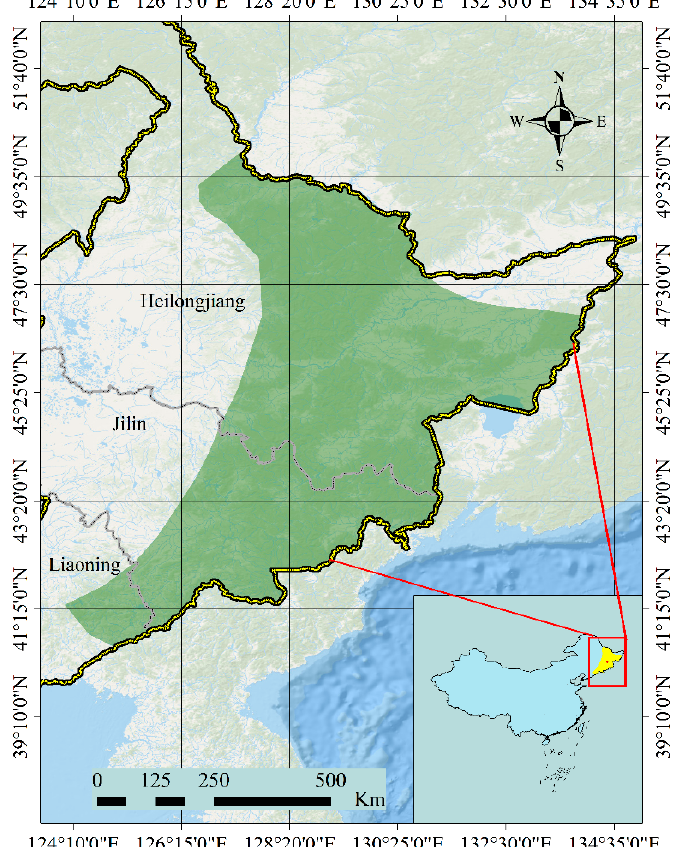
Figure 1. Distribution of Pinus koraiensis in China.